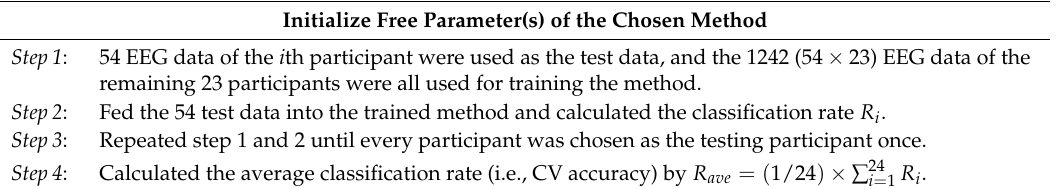
Table 1. The leave-one-participant-out cross validation (LOPO-CV) procedure.